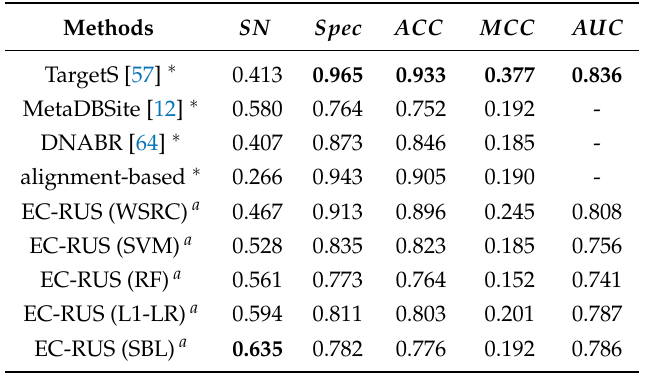
Figure 7. Results for different thresholds of probability on Independent test set of PDNA-52. Rate p/n means the ratio between the predictive number of binding sites and the predictive number of non-binding sites. Table 6. Comparison with some state-of-the-art works on PDNA-52 dataset under maximizing the value of MCC